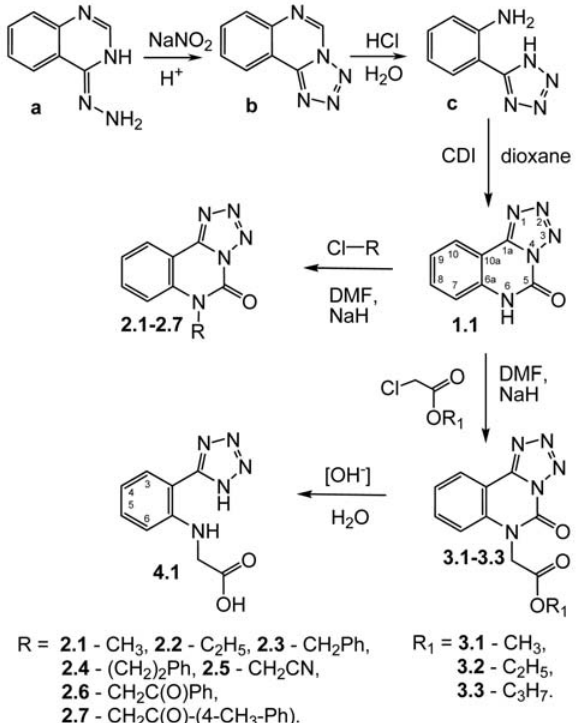
Scheme 1. Synthesis of tetrazolo [ 1,5- c ] quinazolin-5(6 H )-one ( 1.1 ) and its N -substitued